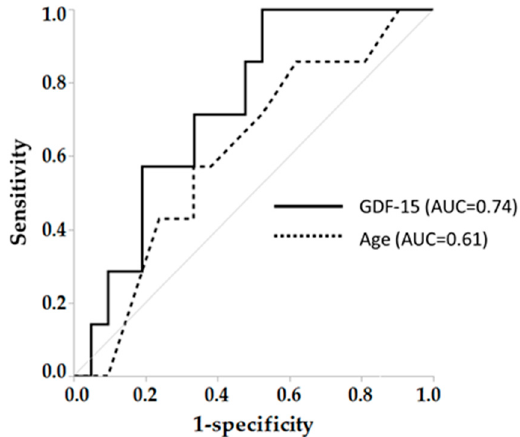
Figure 5. Diagnostic ability in GDF-15 and age to identify MCR in COPD. AUC: Area under the curve, MCR: Motoric cognitive risk syndrome. Arrows mean cut-off point to identify coexistence of sedentary lifestyle and cognitive risk (MCR).